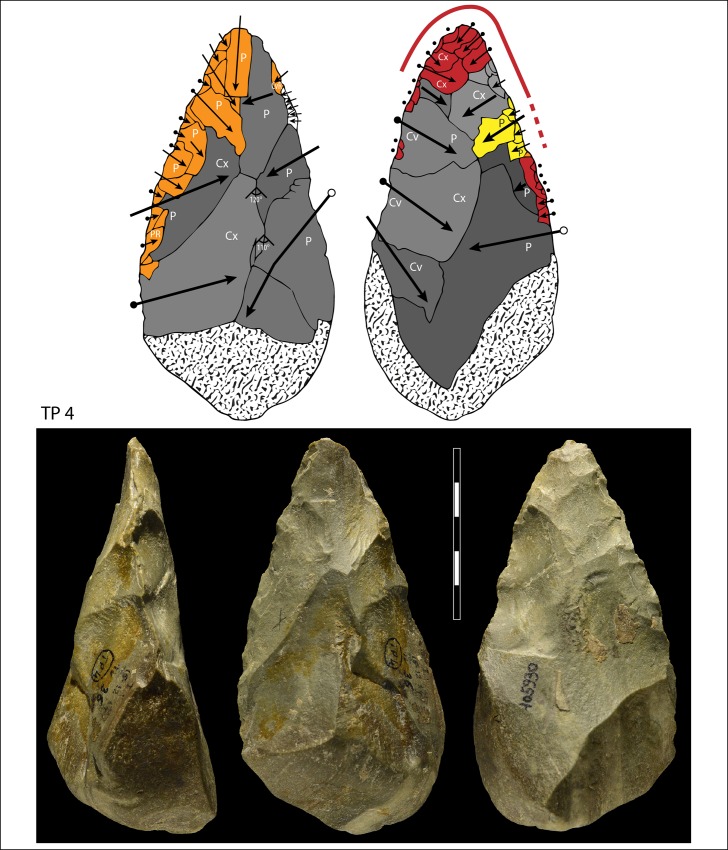
TP4, siliceous limestone.Symbols in drawing as in Fig 10.